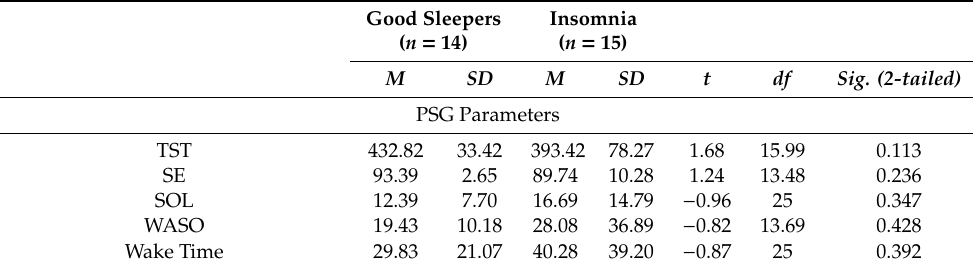
Table 2. Group comparisons and means and standard deviations for PSG sleep, sleep diary, and the discrepancy between objective and subjective